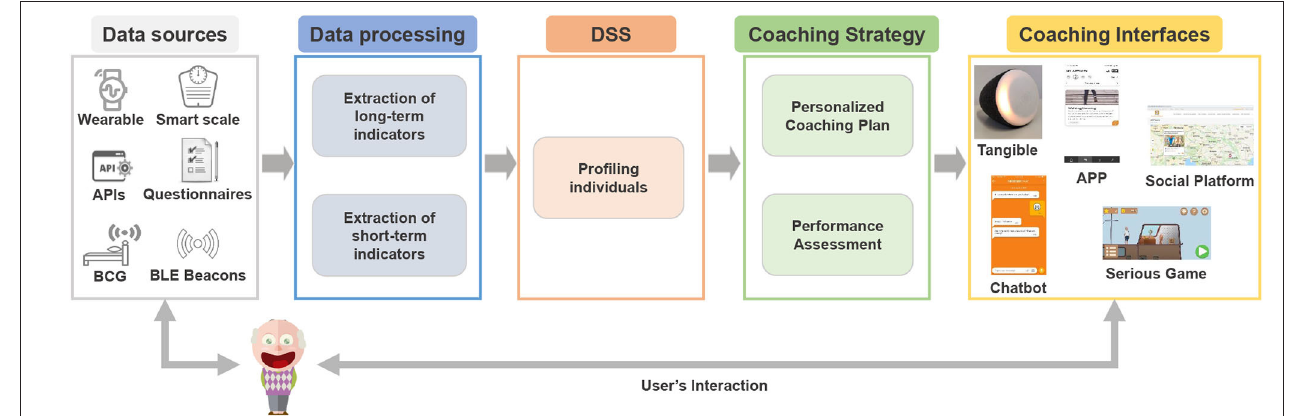
FIGURE 2 | The NESTORE coaching